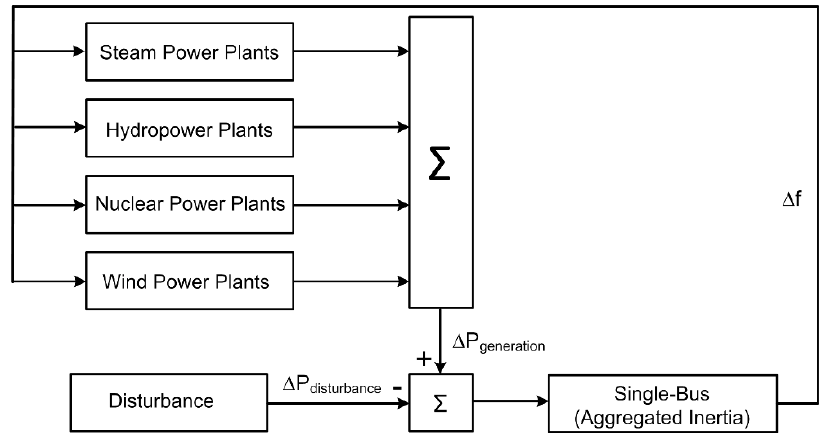
Figure 1. Single-bus representation of a benchmark power system model with wind power plants. Table 1. Different wind power penetration levels in benchmark power system model.